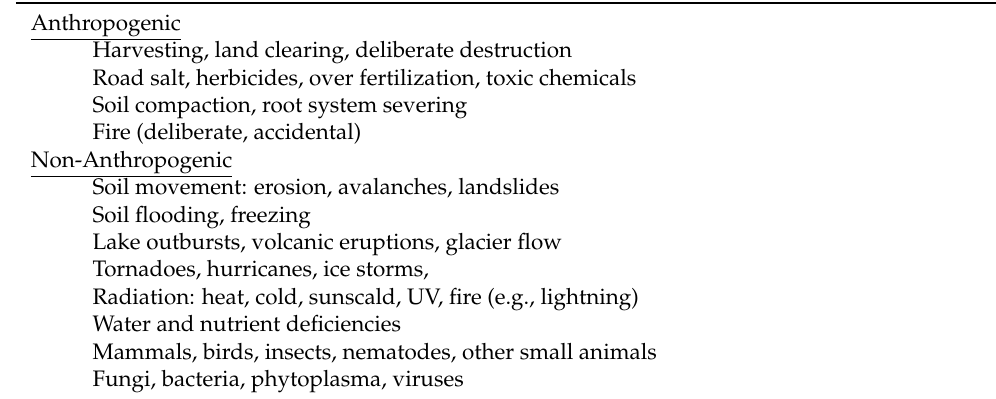
Table 1. Some environmental factors associated with tree